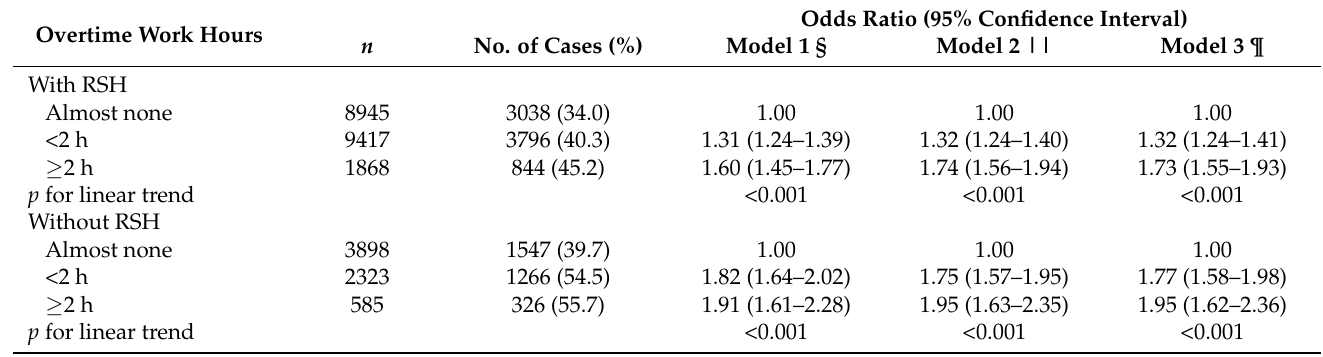
Table 3. Association between overtime work hours and psychological distress † by RSH ‡: multiple logistic regression